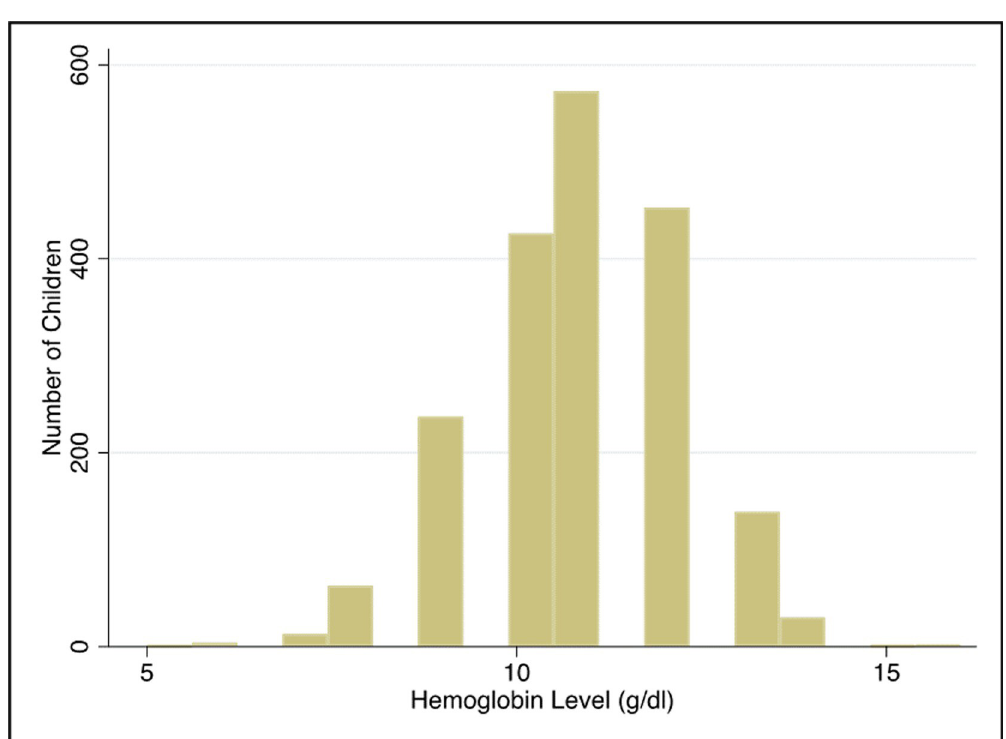
Fig 2. Distribution of hemoglobin level among Nepalese